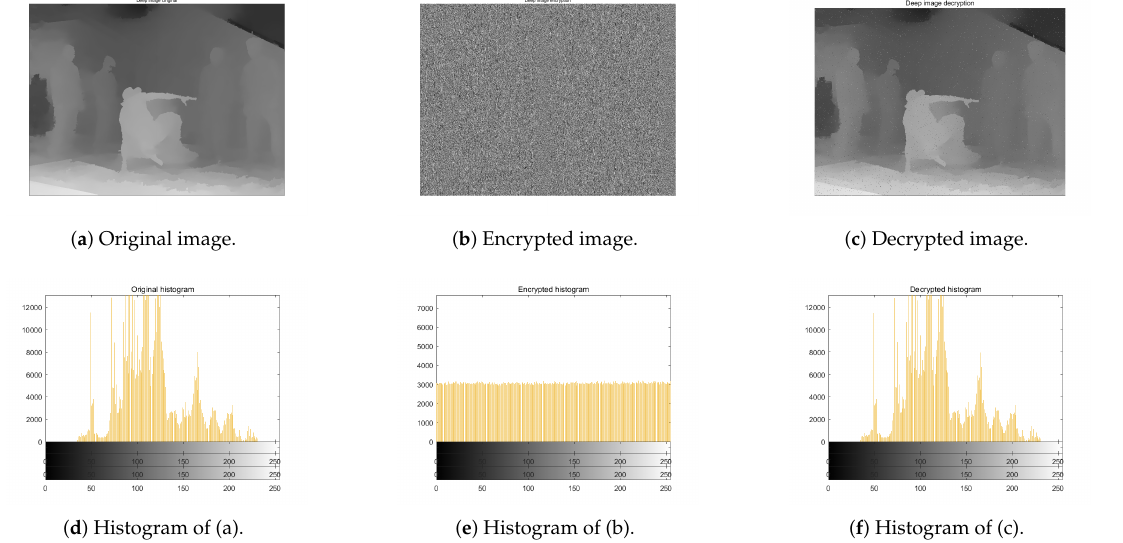
Figure 6. Encryption and decryption of depth